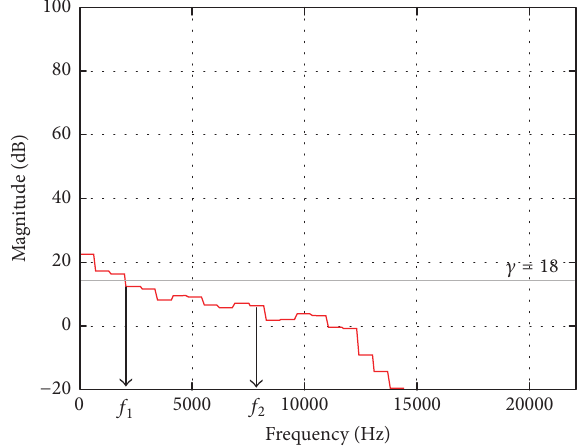
Figure 5: Average SMR (red) and an example of selecting the frequency band [𝑓 1 ,𝑓 2 ] given the SMR criterion 𝛾 = 18 dB. If the frequency bandwidth 𝑓 2 − 𝑓 1 is wider than 10kHz, it is limited to